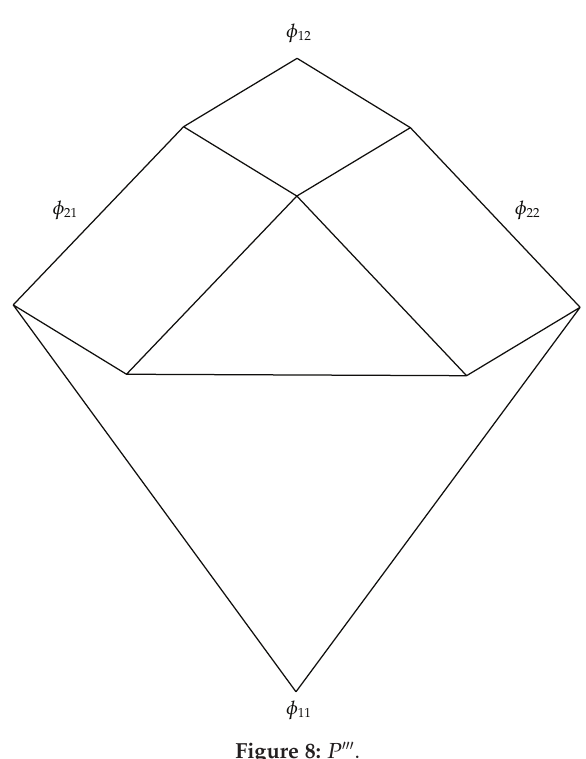
Figure 8: P (cid:2)(cid:2)(cid:2)